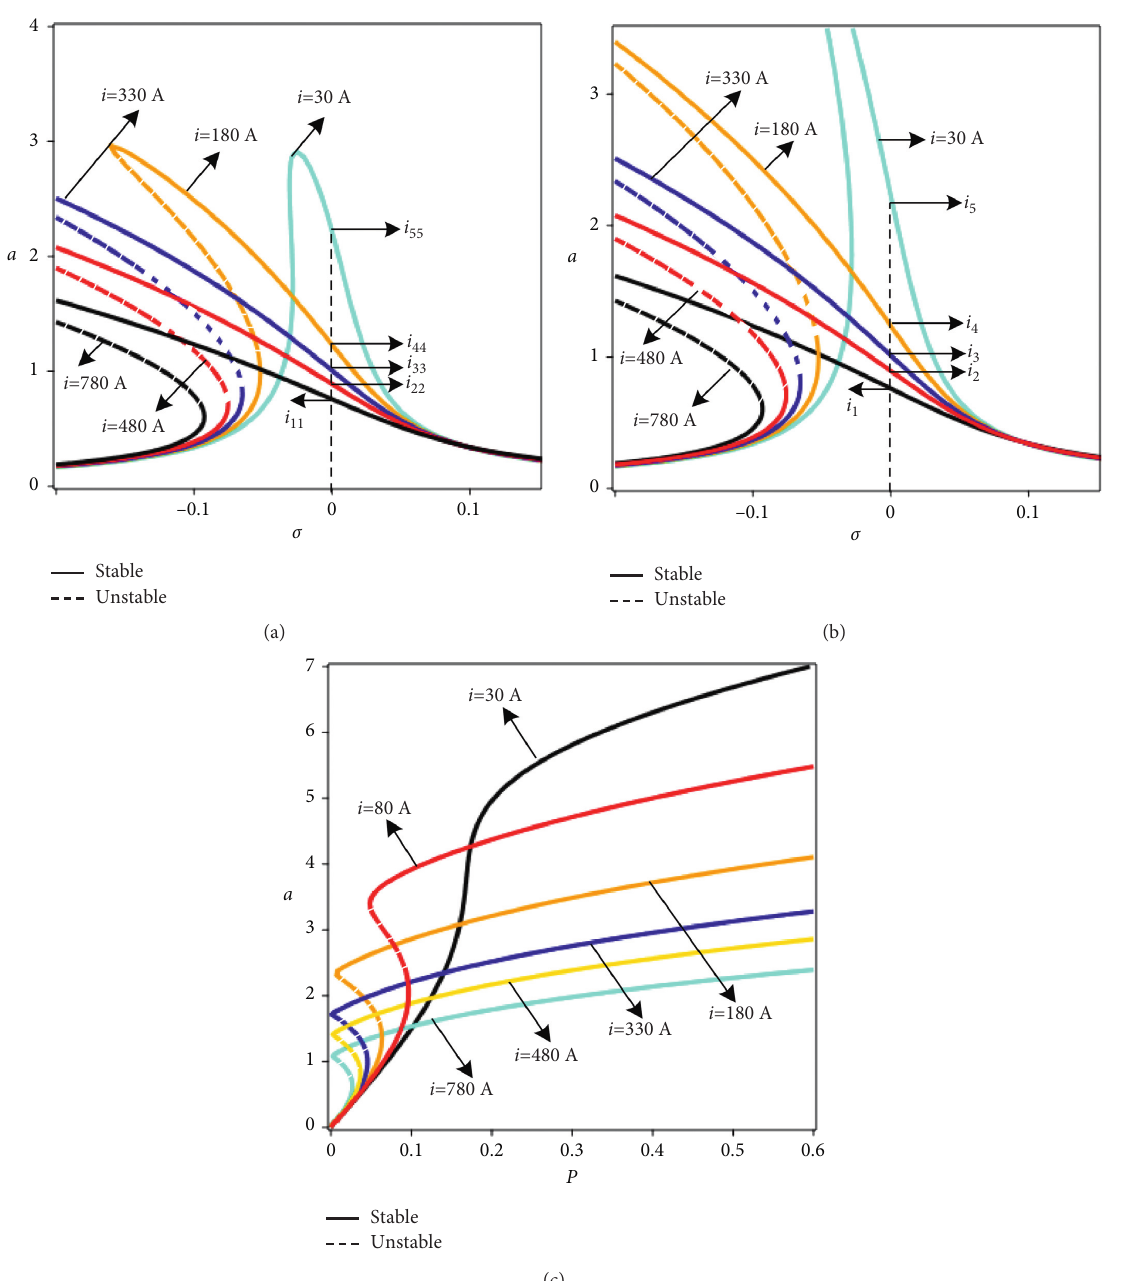
Figure 4: The amplitude-frequency response curve of primary resonance (varied (i)) (a) considering aerodynamic force; (b) without considering aerodynamic force; (c) with different excitation amplitudes ( σ �−